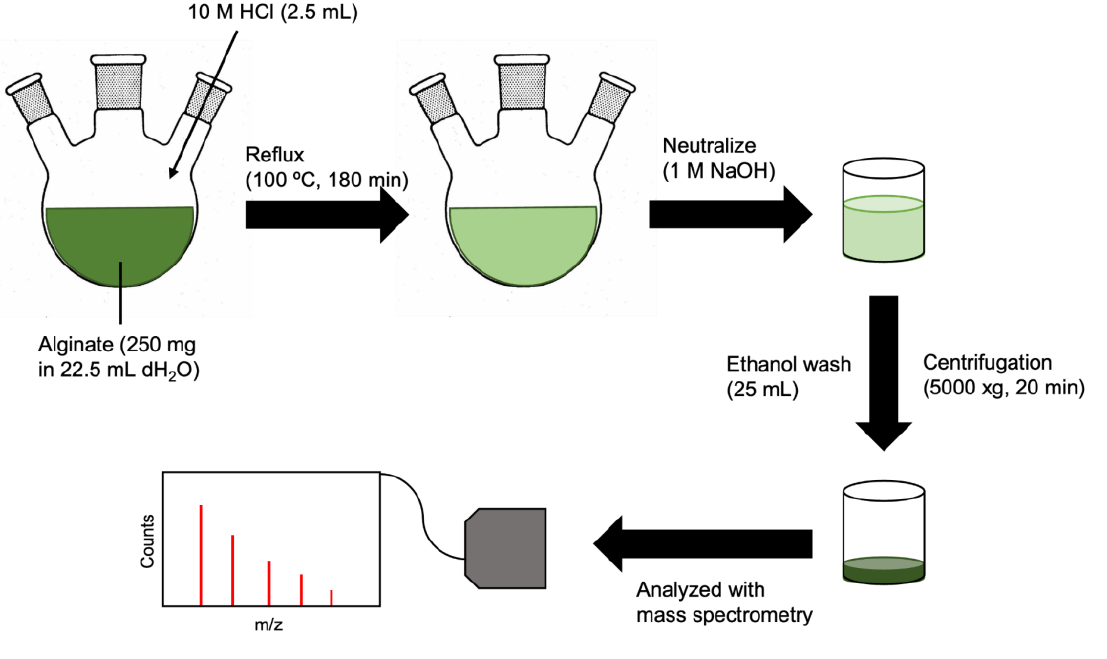
Figure 2. Schematic of alginate breakdown by acid